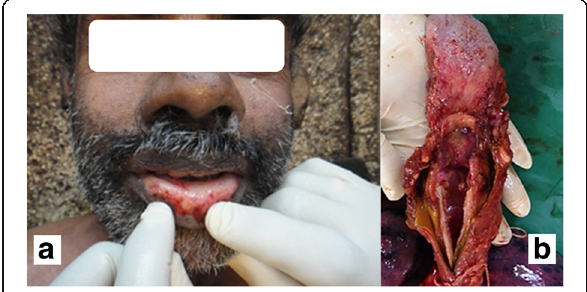
Fig. 1 a Erosion and haemorrhages over the lip. b Erosion and haemorrhages over the tongue